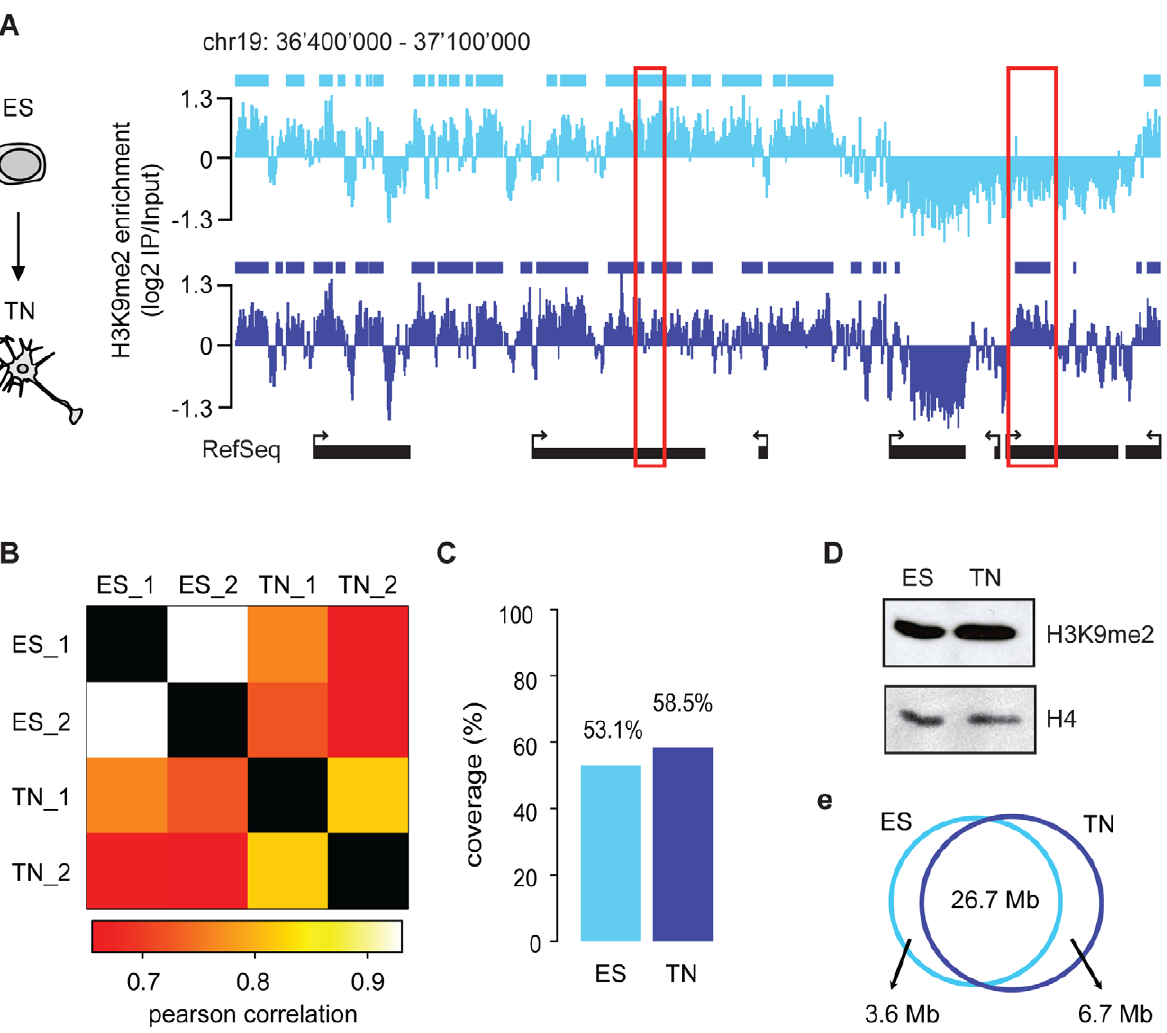
Figure 1. H3K9me2 covers large domains in pluripotent stem cells and derived neurons and is largely invariant between both states. (A) H3K9me2 localization in ES cells and neurons at a representative chromosomal region. Bars above each track indicate H3K9me2 domains determined by HMM. The red boxes highlight two regions that lose and gain H3K9me2, respectively. (B) Pair-wise correlation of H3K9me2 signal among different samples and experiments. Biological replicates are indicated as 1 and 2. Pearson correlations of IP/Input ratios were calculated for 500 bp windows on chromosome 19 (white/yellow corresponds to higher correlations). (C) Quantification of genomic coverage of H3K9me2 in ES cells and neurons applying a two-state HMM (i.e. ‘‘high’’ or ‘‘low’’). Shown is the percentage of chromosome 19 that is in an H3K9me2 ‘‘high’’ state (i.e. enriched for H3K9me2) in both biological replicates. The value was normalized to the total coverage of the tiled region on the array. (D) Western blot detection of H3K9me2 levels in ES cells and neurons (TN). (E) Venn diagram showing the overlap of H3K9me2 enriched regions between ES cells and neurons (TN).